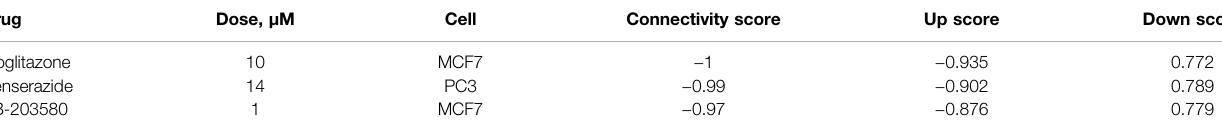
TABLE 3 | | Three bioactive compounds with the top three negative connectivity scores in the CMap analysis.